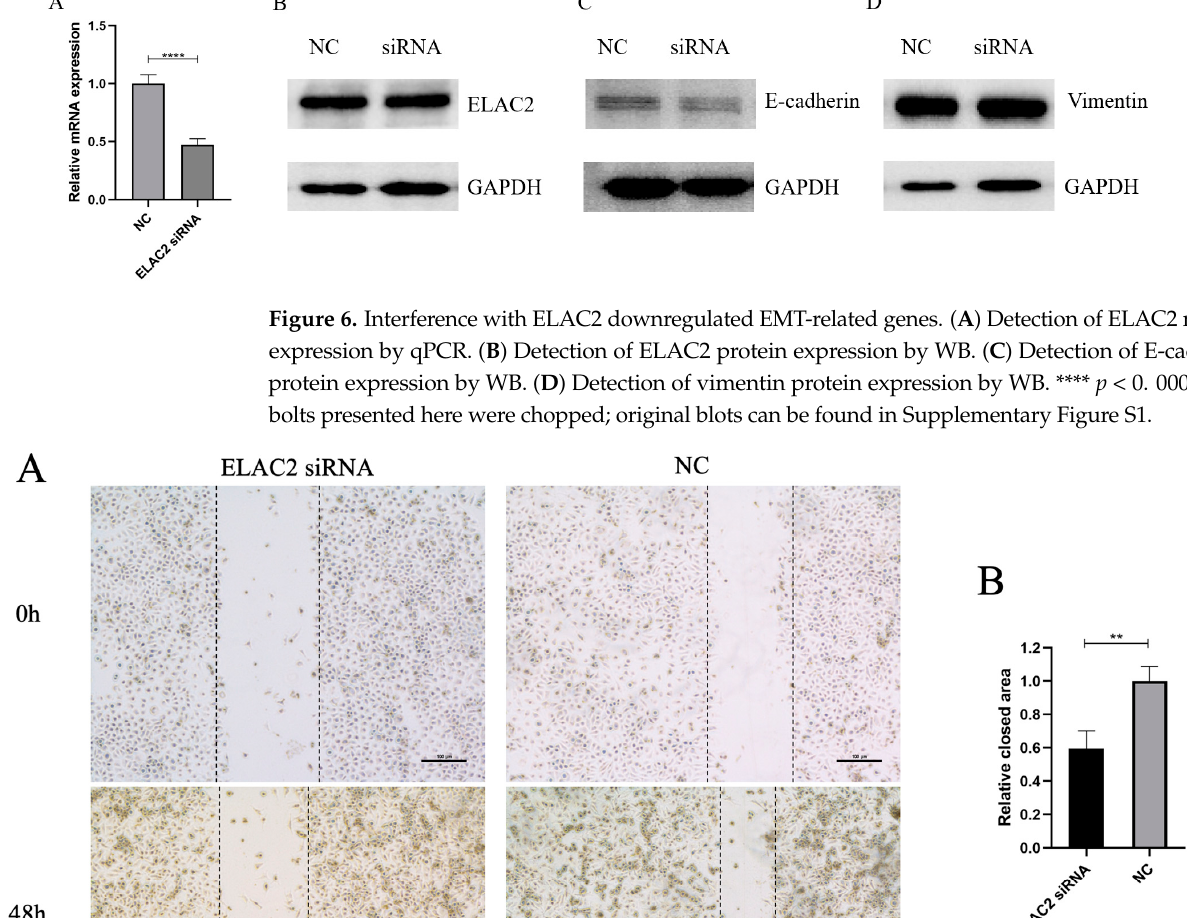
Figure 5. Detection of gene expression in mouse placenta at different developmental stage. ( A ) De- tection of ELAC2 mRNA expression by qPCR. ( B ) Detection of RFTN2 mRNA expression by qPCR. ( C ) Detection of RNF24 mRNA expression by qPCR. ( D ) Detection of ZBTB26 mRNA expression by